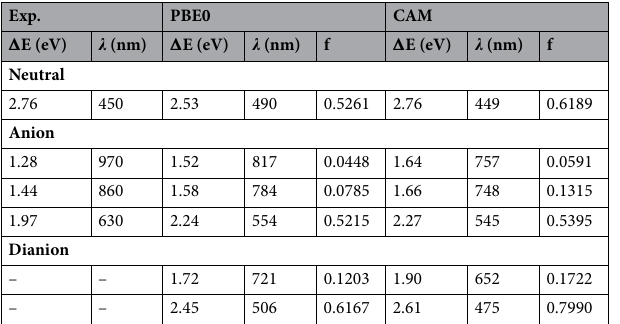
Table 3. Excitation energies for states with oscillator strengths larger than 0.02 for the neutral, monoanionic, and dianionic species of PTTE obtained via regular TD-DFT/aug-cc-pVDZ calculations employing